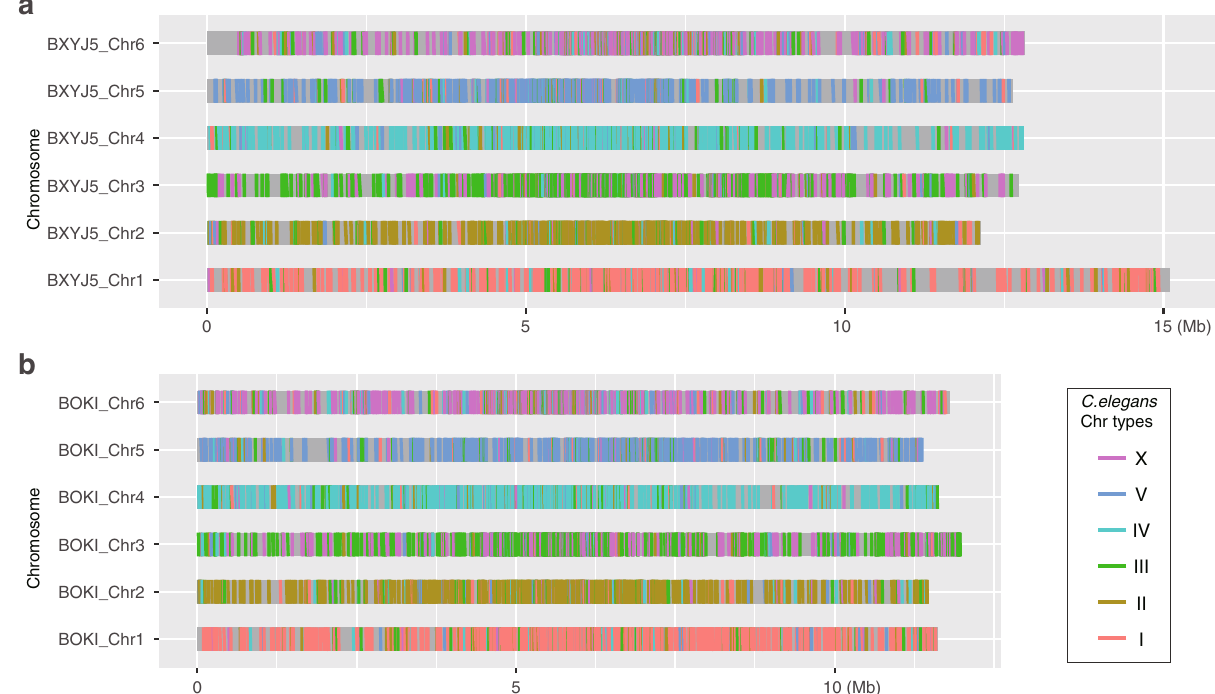
Fig. 1 Schematic overview of the six chromosomes of B. xylophilus and B. okinawaensis . a B. xylophilus . b B. okinawaensis . One-to-one orthologs with C. elegans genes were used to visualize syntenic relationships.